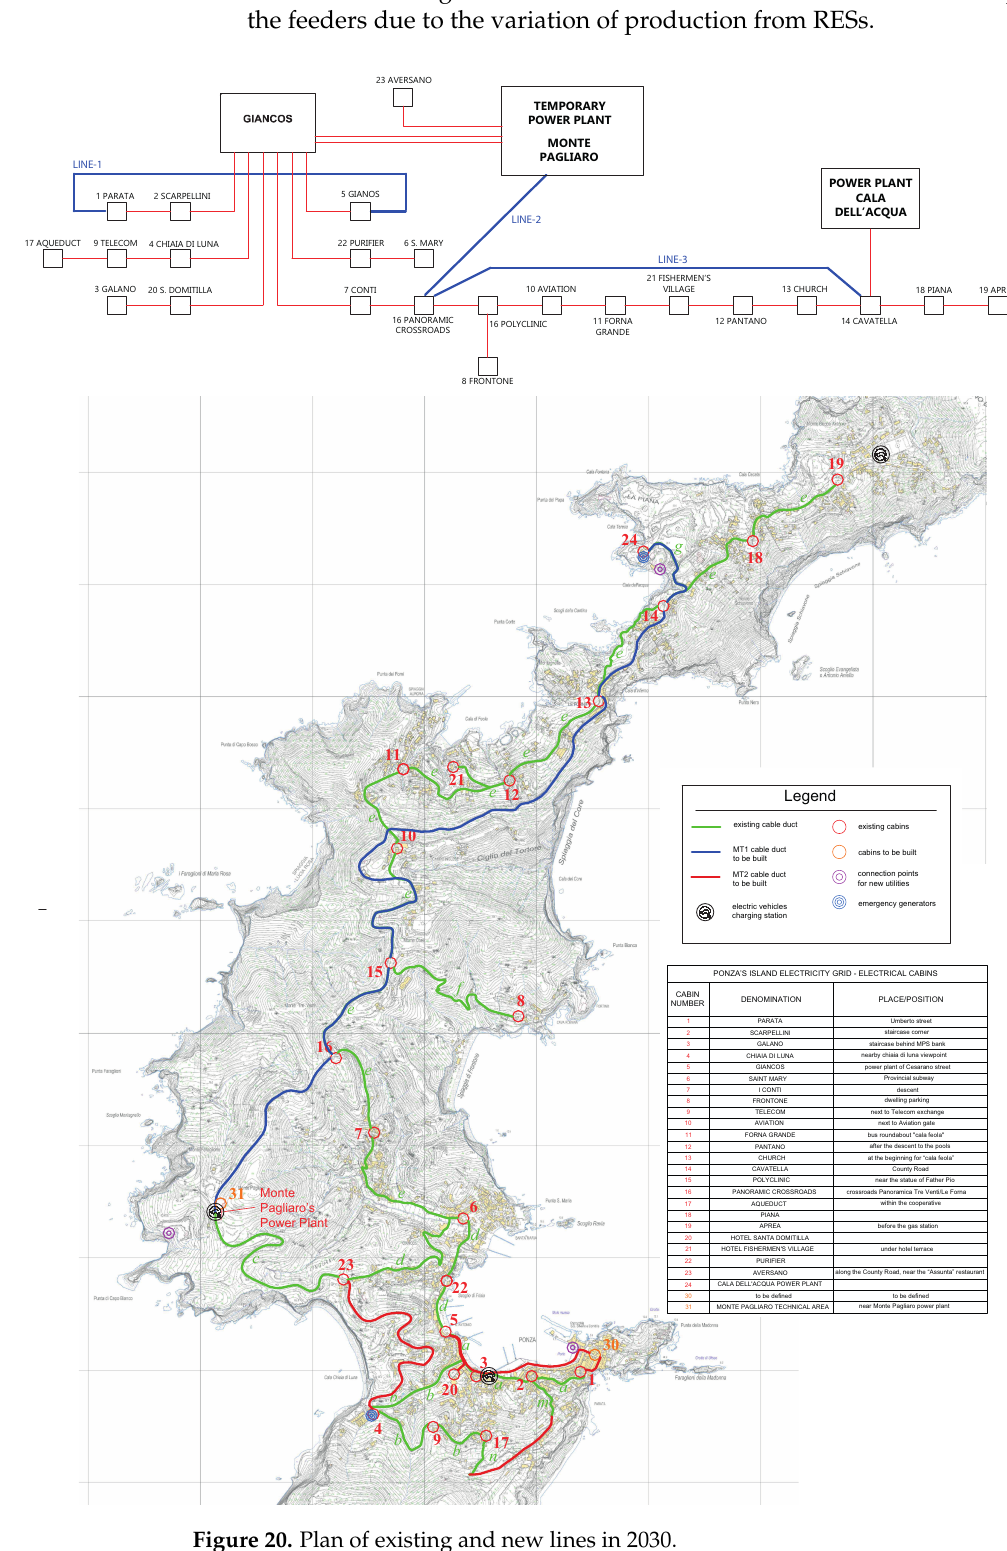
Figure 20. Plan of existing and new lines in